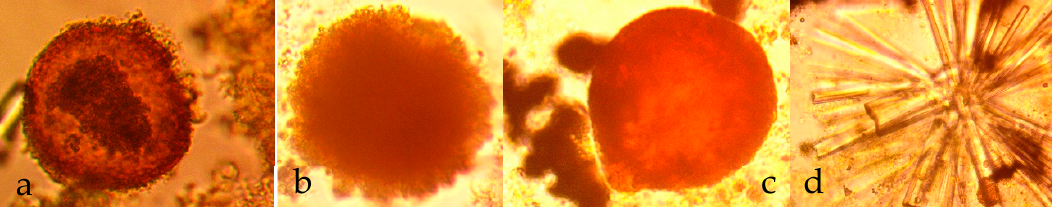
Figure A2. Examples of the polymer spheres in transmitted light: ( a ) Example A1a: Fe(b)Mn(a) polymer where Fe(b) polymer surround a Mn core; Field of view = 0.12 mm; ( b ) Example A1b: Fe(b) polymer; Field of view = 0.11 mm; ( c ) Example A1b: Fe(b) polymer; Field of view = 0.16 mm; ( d ) Example A1b: gypsum flower (CaSO 4 ) in the evaporated water product; Field of view = 0.27 mm;.